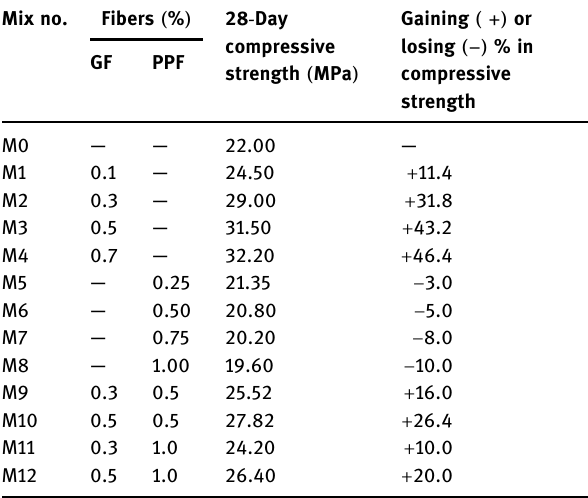
Table 11: Compressive strength test results of LWC mixes Mix no. Fibers ( % ) 28 - Day compressive